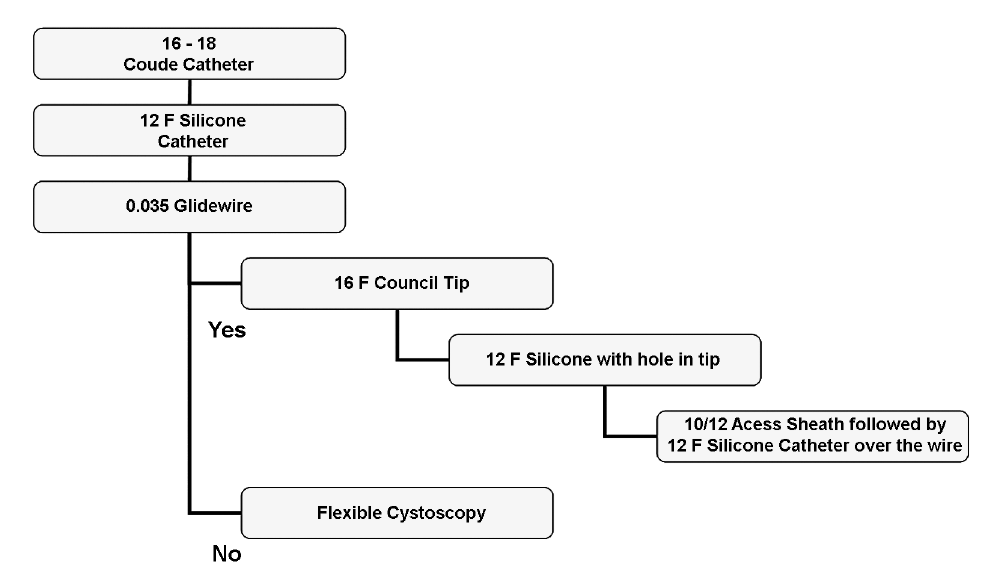
Figure 4 – Difficult urethral catheterization